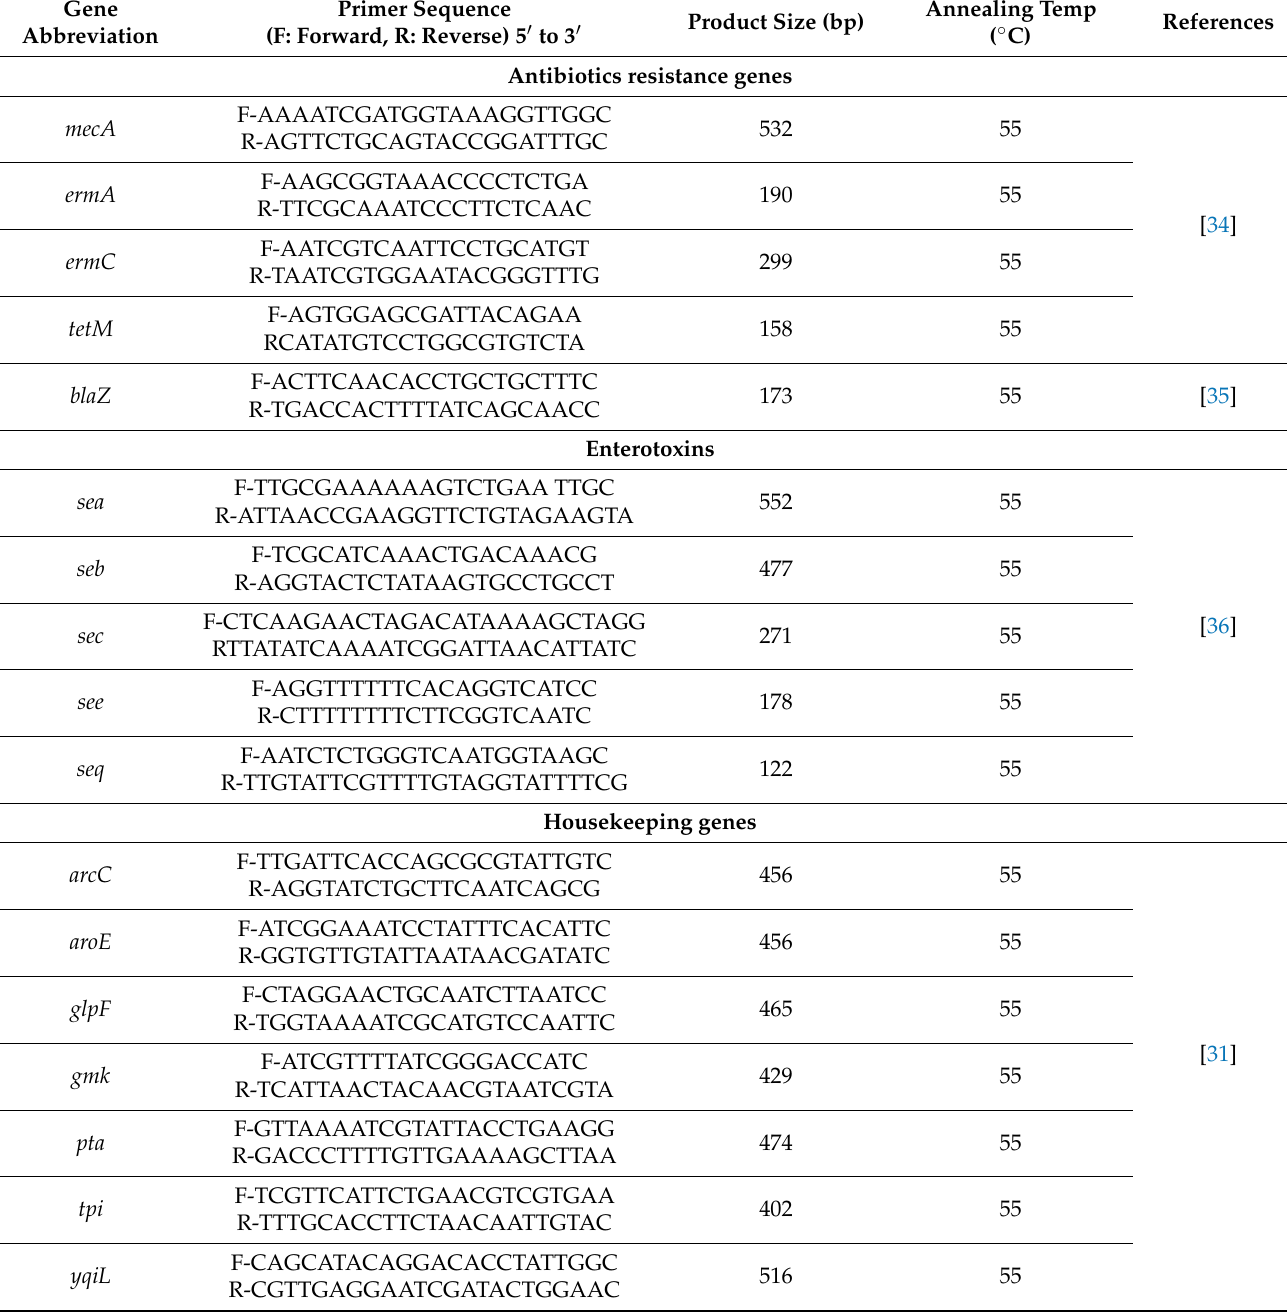
Table 1. Antibiotic-resistance, virulence, and housekeeping gene primers used in this